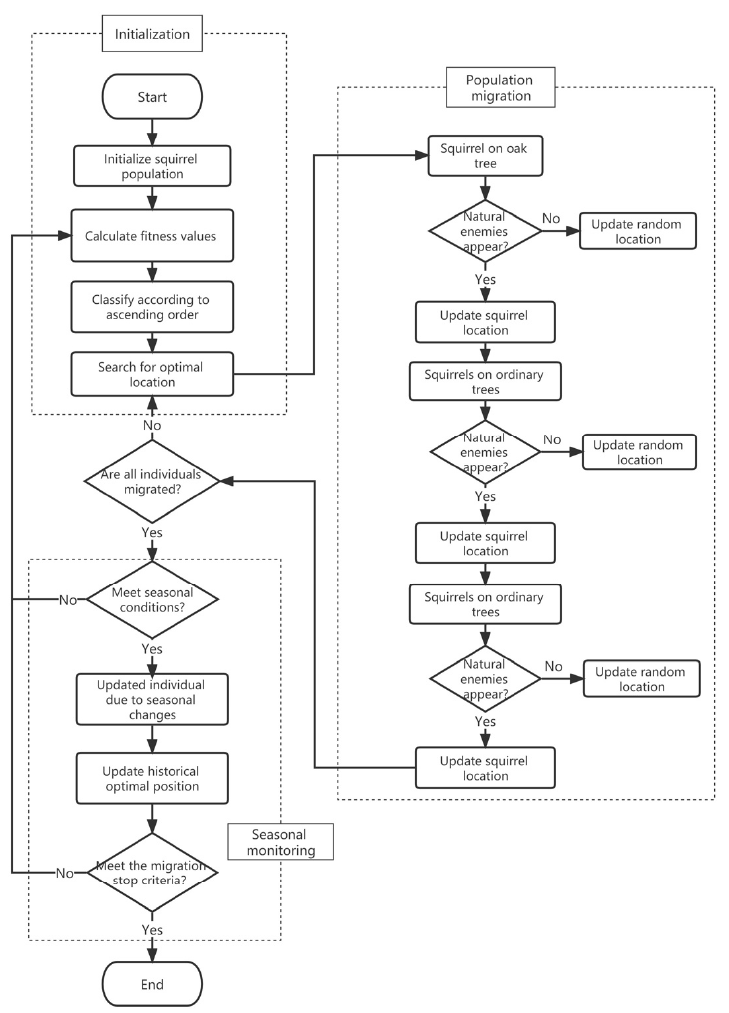
Figure 1. The working process of the SOA-SVM